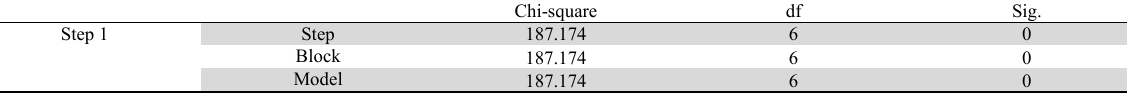
Omnibus Tests of Model Coefficients